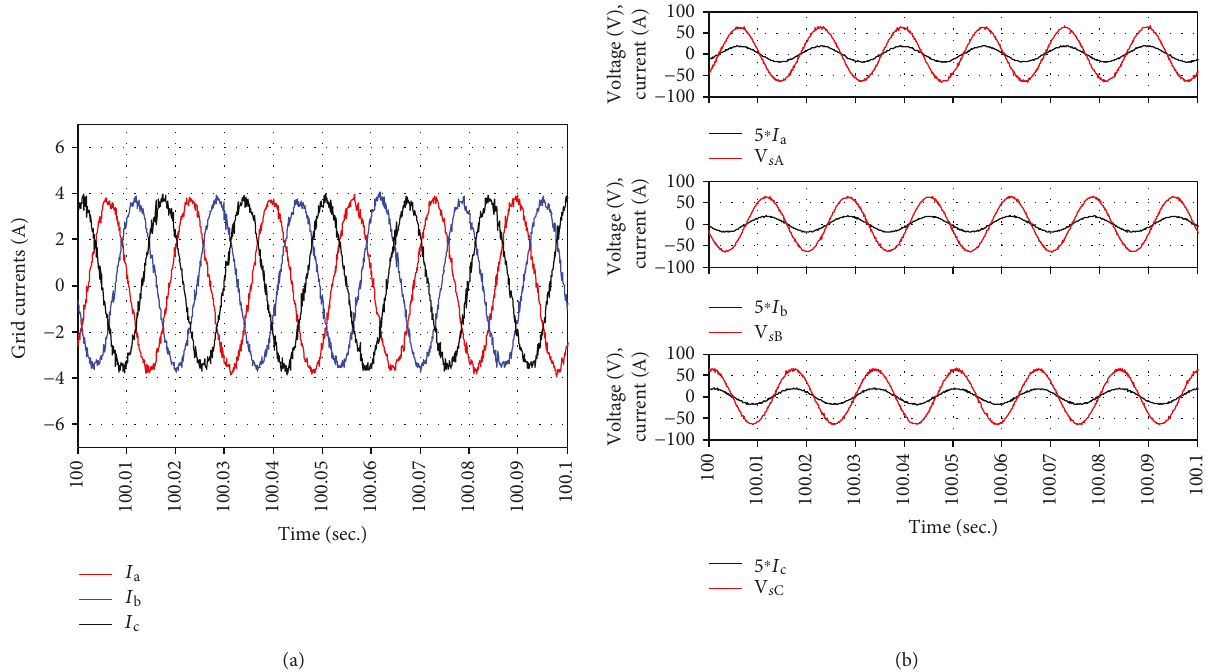
Figure 27: (a) The three-phase grid currents of con fi guration C. (b) Grid voltages and grid currents of con fi guration